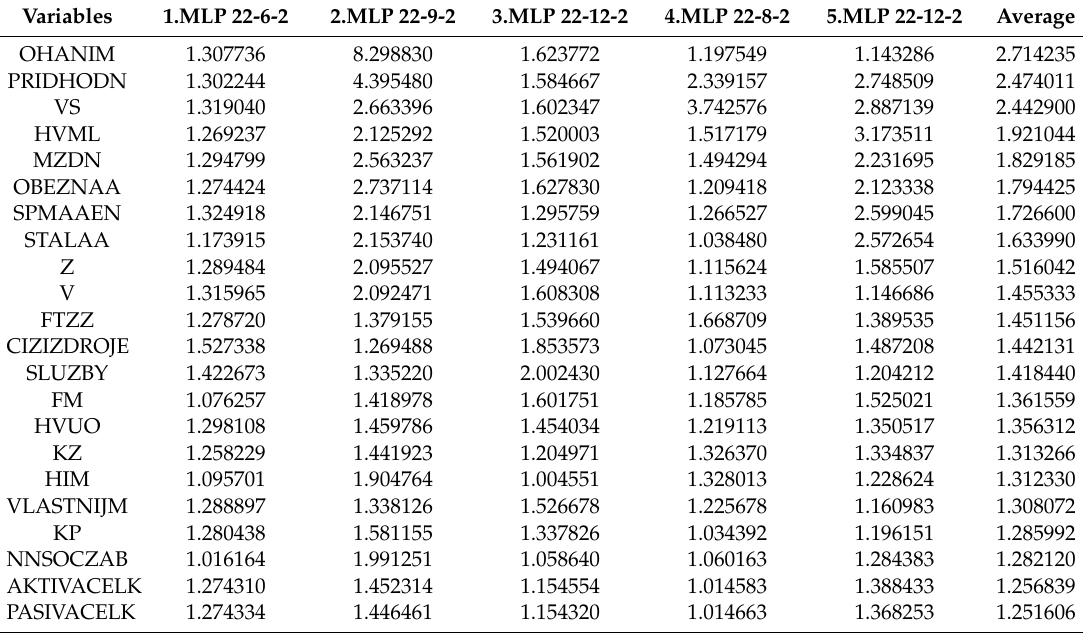
Table 6. Sensitivity